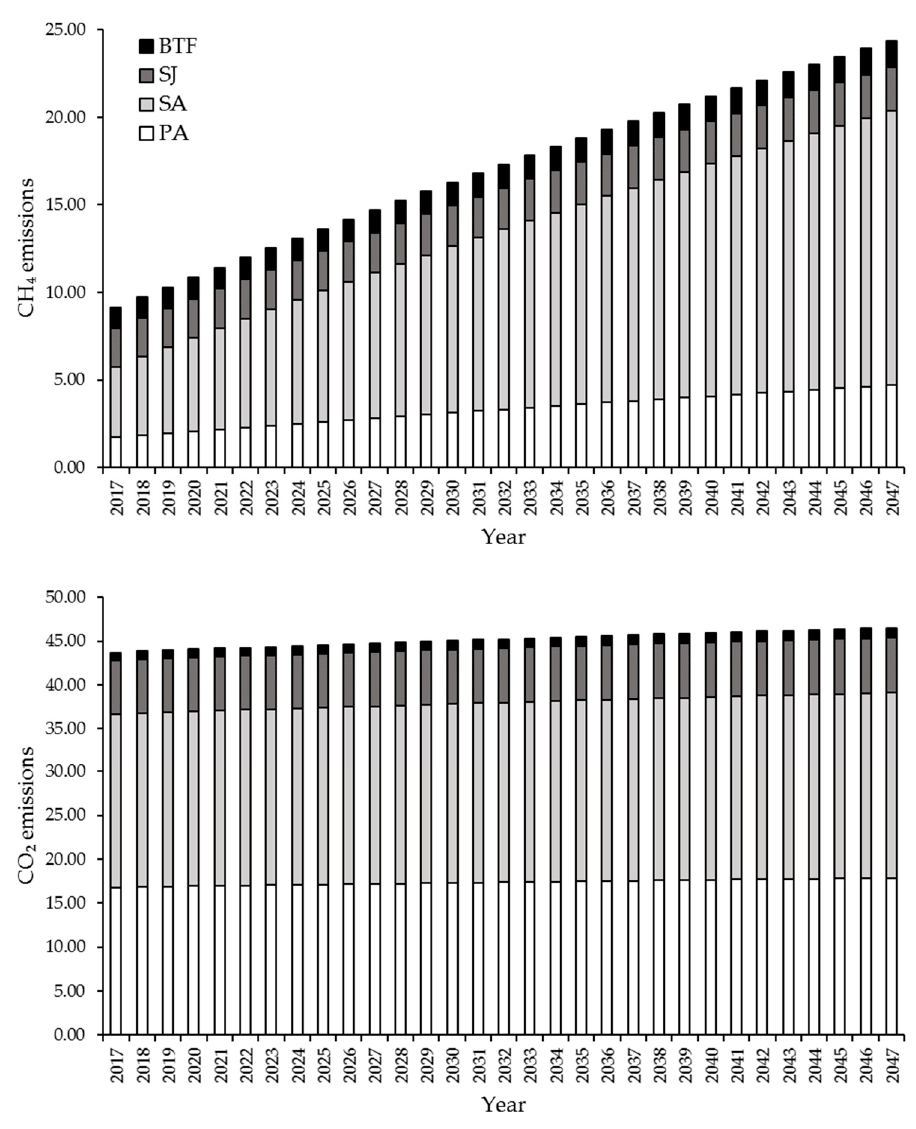
Figure 5. Simulation of CO 2 and CH 4 emission (25 cm depth) over years at the four experimental sites in Ganghwa (in kg ha − 1 yr − 1 ).